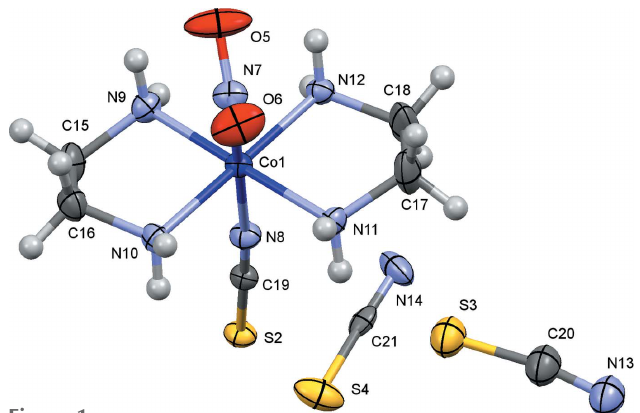
Figure 1 The molecular structure of (I), showing displacement ellipsoids at the 30% probability level. Only one of two possible orientations of the disordered thiocyanate (N13/C20/S3 and N14/C21/S4) ions is indicated for clarity.